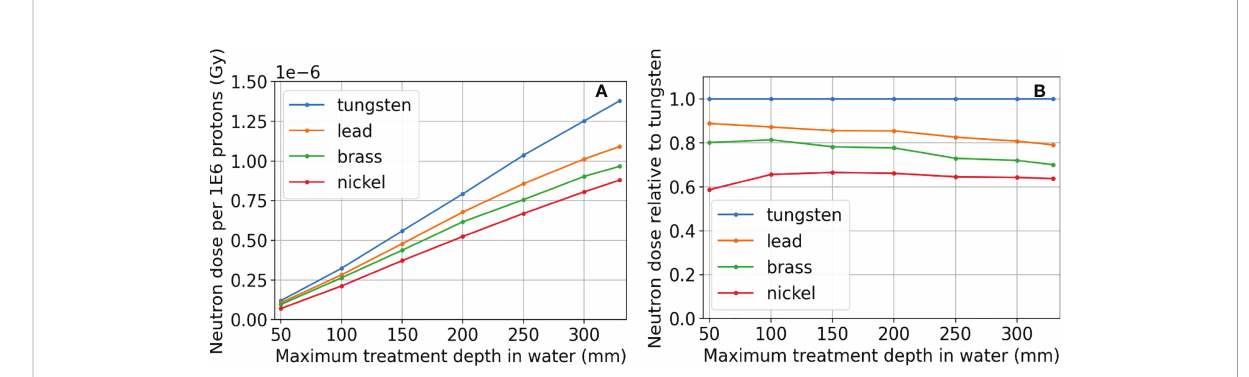
FIGURE 12 Neutron dose results for tungsten, lead, brass, and nickel, where the proton energy was the maximum possible for each aperture thickness. Absolute dose results are in (A) . The neutron doses resulting from apertures using different materials relative to using tungsten are shown in (B) .